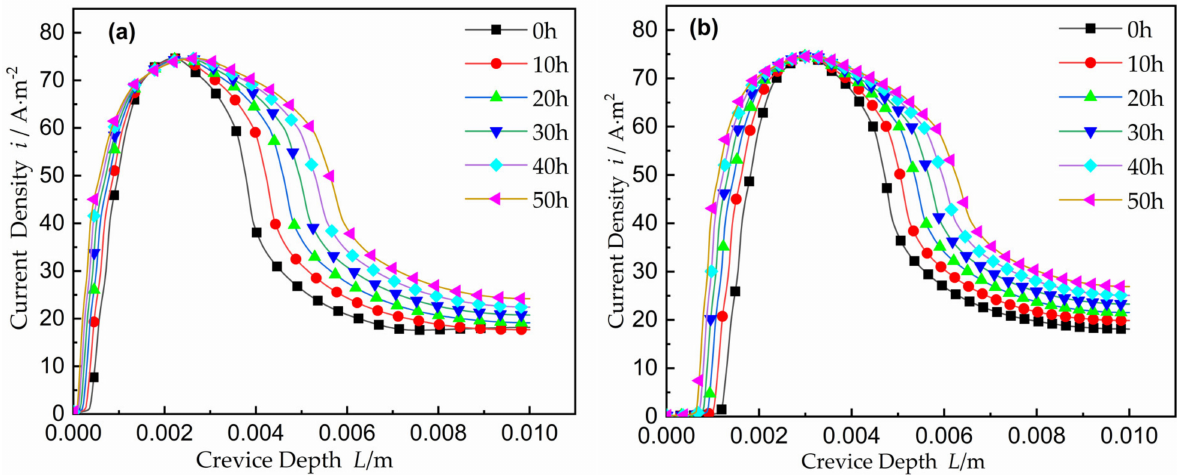
Figure 8. Current density with time for W = 0.3 mm: ( a ) the applied potential E A = 0.25 V; ( b ) the applied potential E A = 0.30